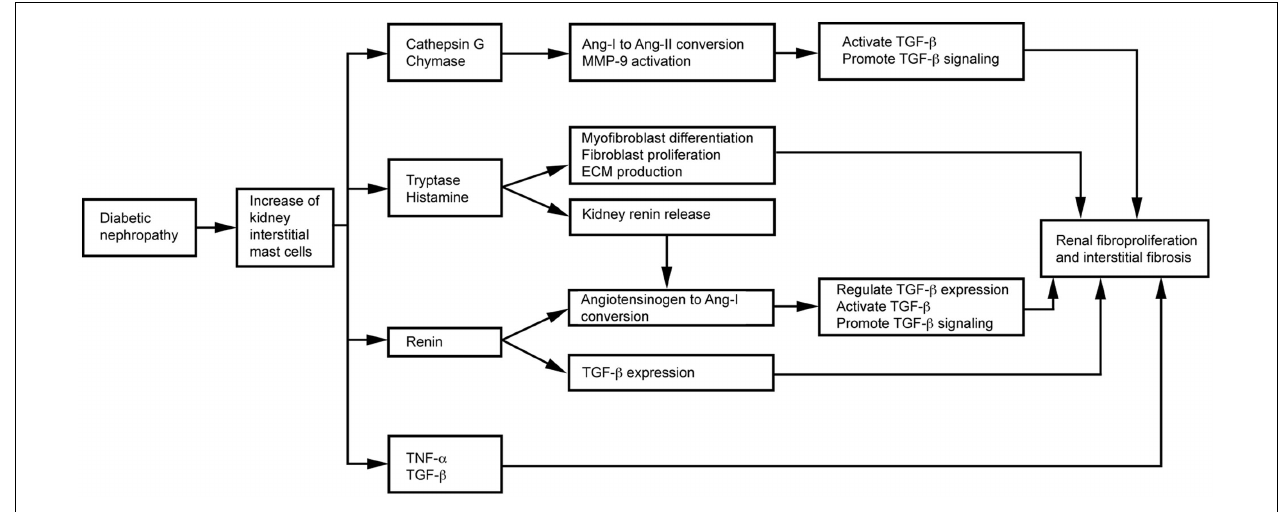
FIGURE 5 | Mast cell functions in diabetic